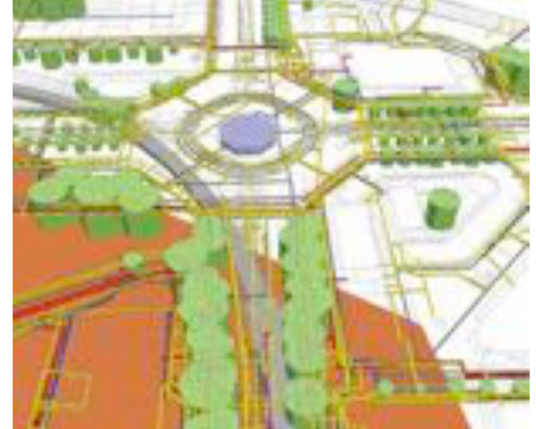
Figure 4. The sewer system of the City of Rotterdam and a set of tree roots modelled as cylinders. The interaction between both datasets is visible as occlusion of urban